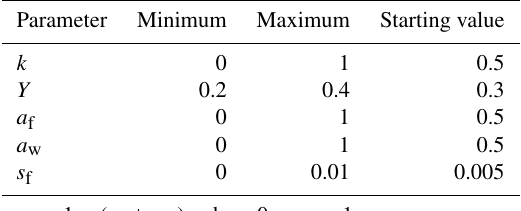
Table 2. Prior parameter PDFs (with uniform distribution) and the starting point of the iteration for all